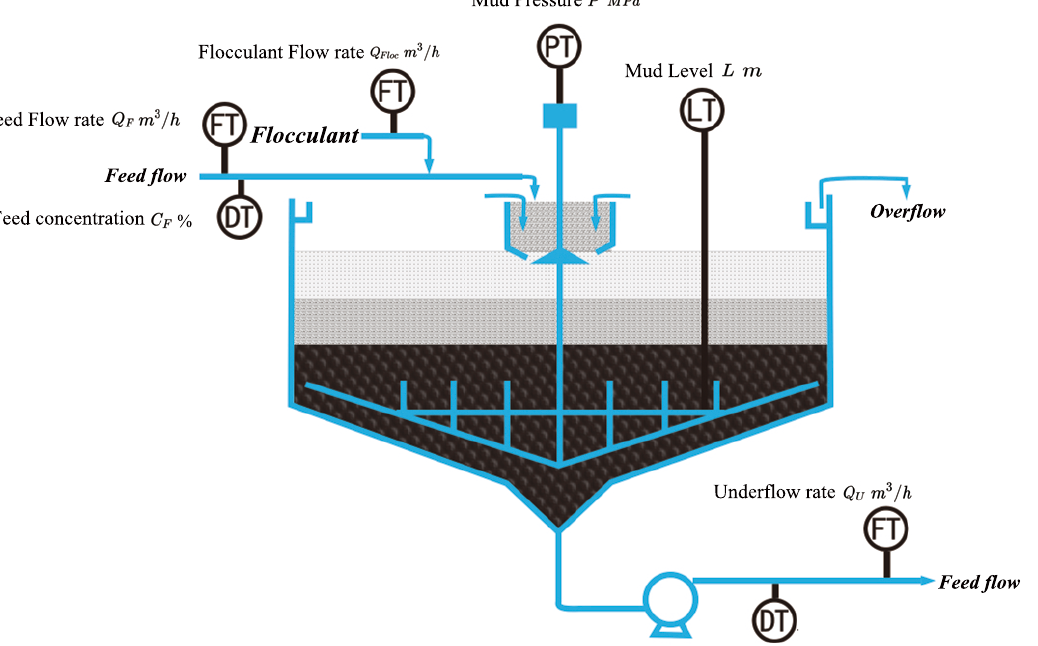
Figure 1. Working process of thickener is continuous. Crude low concentration slurry flow was fed into the mix tank accompanied with flocculant. The dissolved particles agglomerate to larger lump under the effect of flocculant and concentrate at the bottom of thickener. Underflow with high concentration is produced and clear water will be recycled from the overflow pipe which locates at the top of